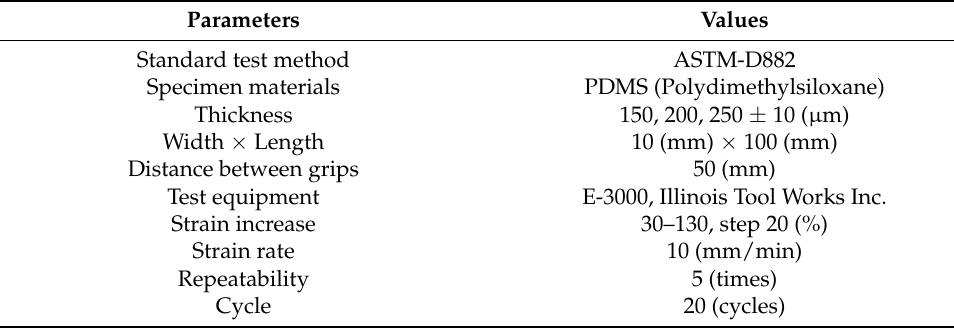
Figure 2. Schematic diagram of the specimen dimensions. Table 1. Experimental parameters of the cyclic tensile test.